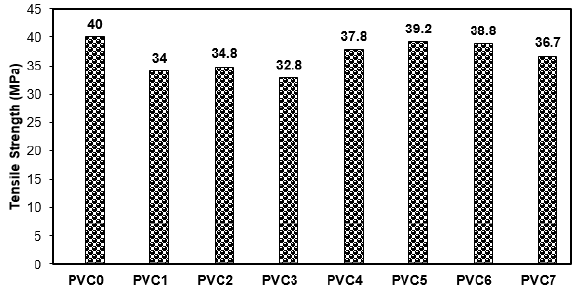
Figure 1: Tensile strengths of PVC formulations without flame retardant and with ZB, ATH and MH.